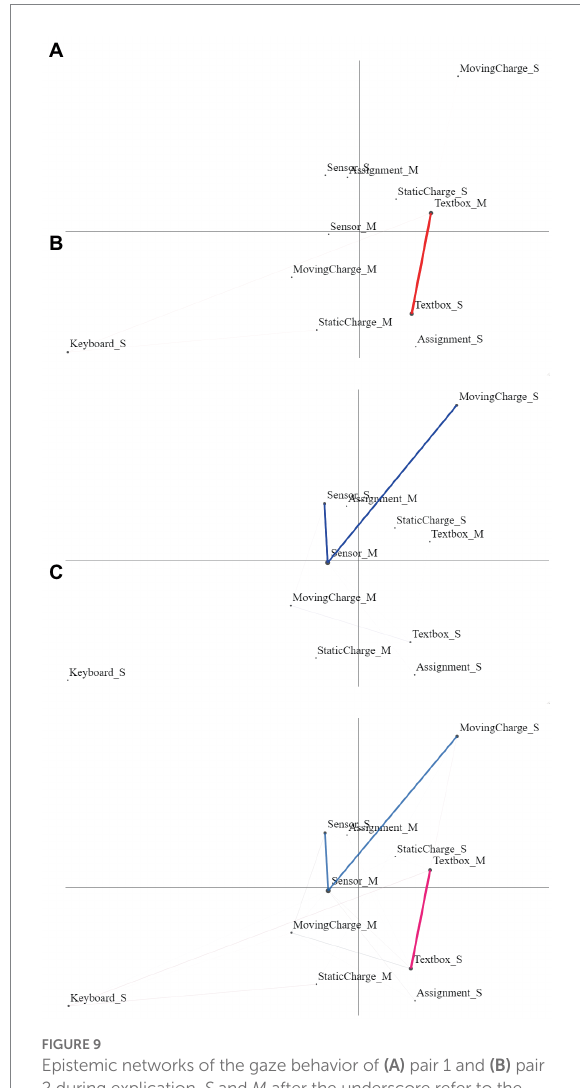
FIGURE 8 Epistemic networks of the gaze behavior of (A) pair 1 and (B) pair 2 when presenting new ideas. S and M after the underscore refer to the gaze of the sharing student (1S/2S) and monitoring student (1M/2M). The difference between epistemic networks (A,B) is presented in (C) . The red edges show the connections between the nodes that were stronger among pair 1 than among pair 2. The blue edges show the connections between the nodes that were weaker among pair 1 than among pair 2.